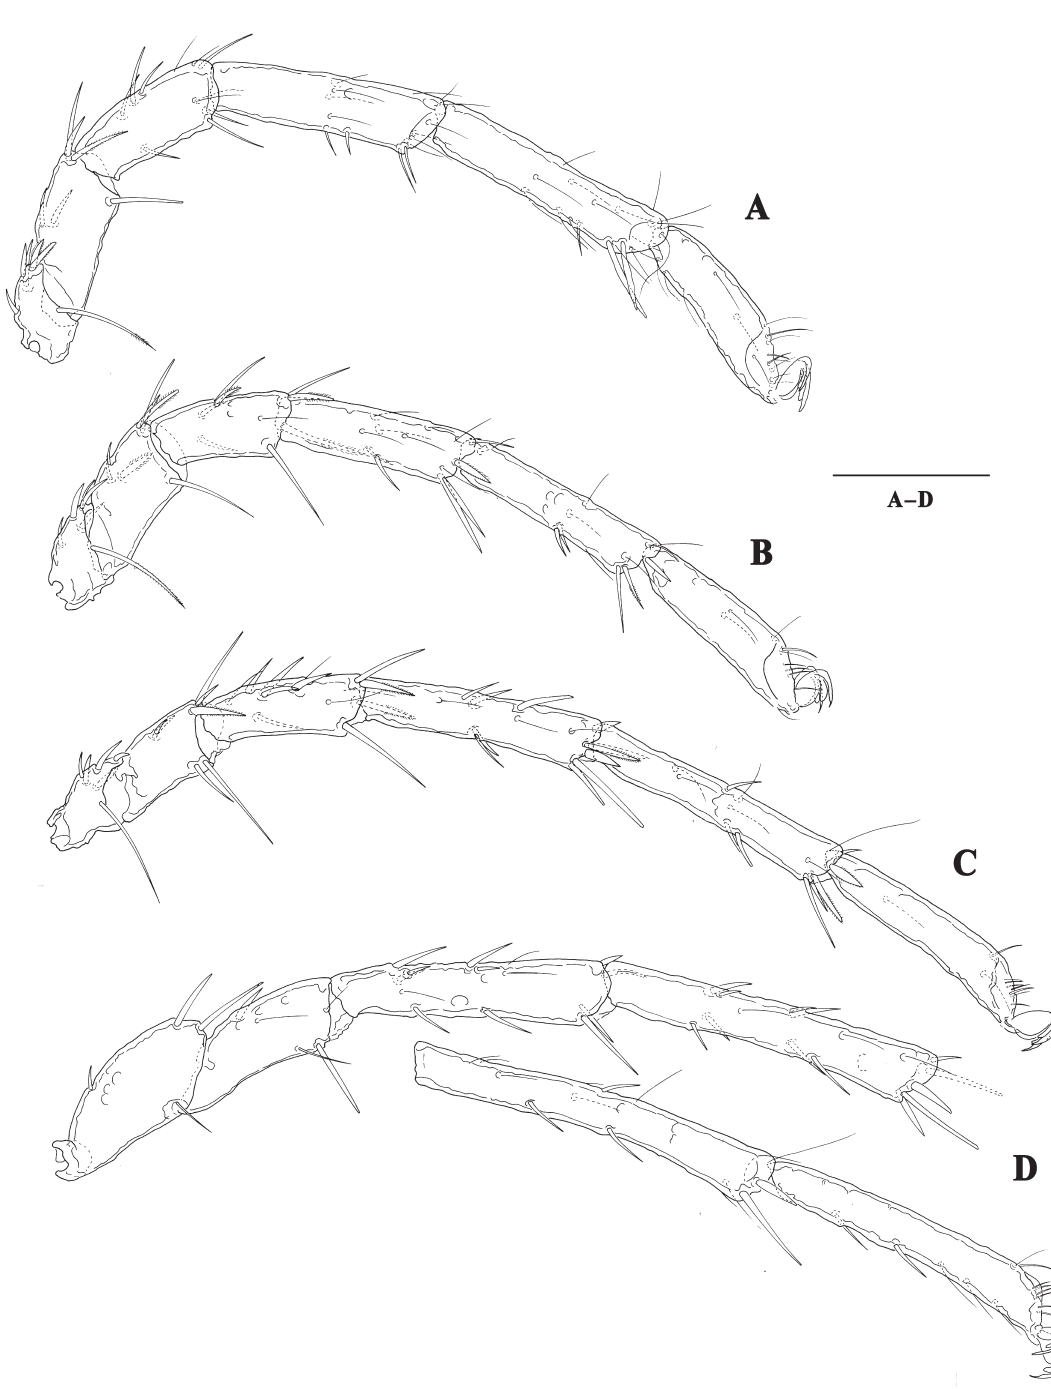
Fig. 10. Atractides ( Atractides ) longiprojectus Zhang, Li & Guo sp. nov., holotype, ♀ (GUGC, Slide No. QH-HY-2020072907). A–D . I-L–IV-L. Scale bar = 100